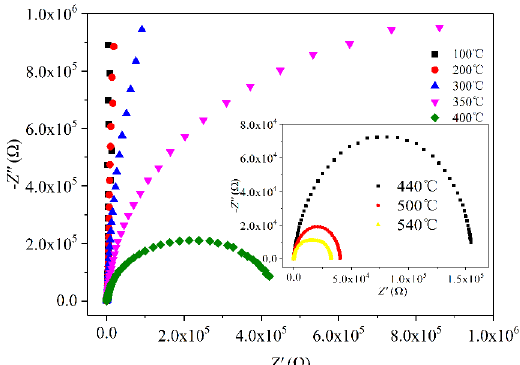
) of BNBT- x NT ceramics m